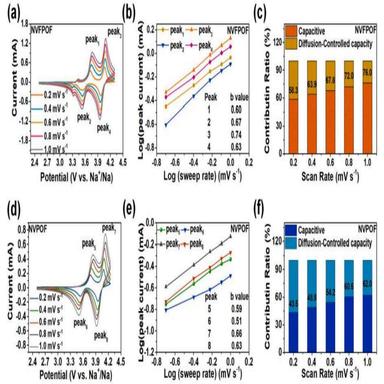
CV curves of NVFPOF electrode (a) at 0.2–1.0 mV s − 1 ; (b) Log(i)-log(v) graph; (c) Estimated capacitance contribution at different scanning rates; CV curves of NVPOF electrode (d) at 0.2–1.0 mV s − 1 ; (e) Log(i)-log(v) graph; (f) Estimated capacitance contribution at different scanning rates.